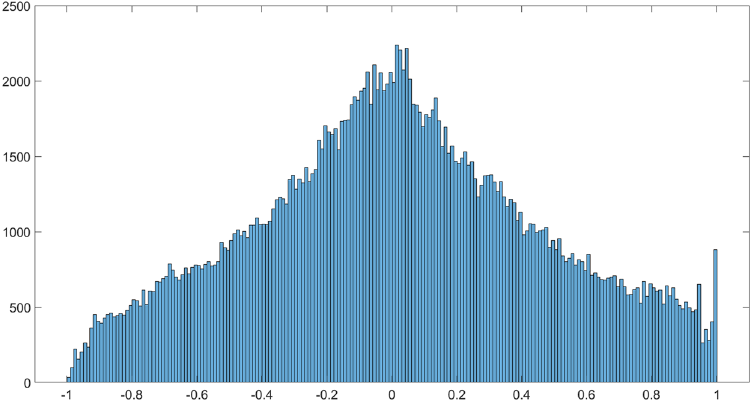
Figure 8. Histogram of correlation coefficients between 455 color and texture indices of 6383 RGB